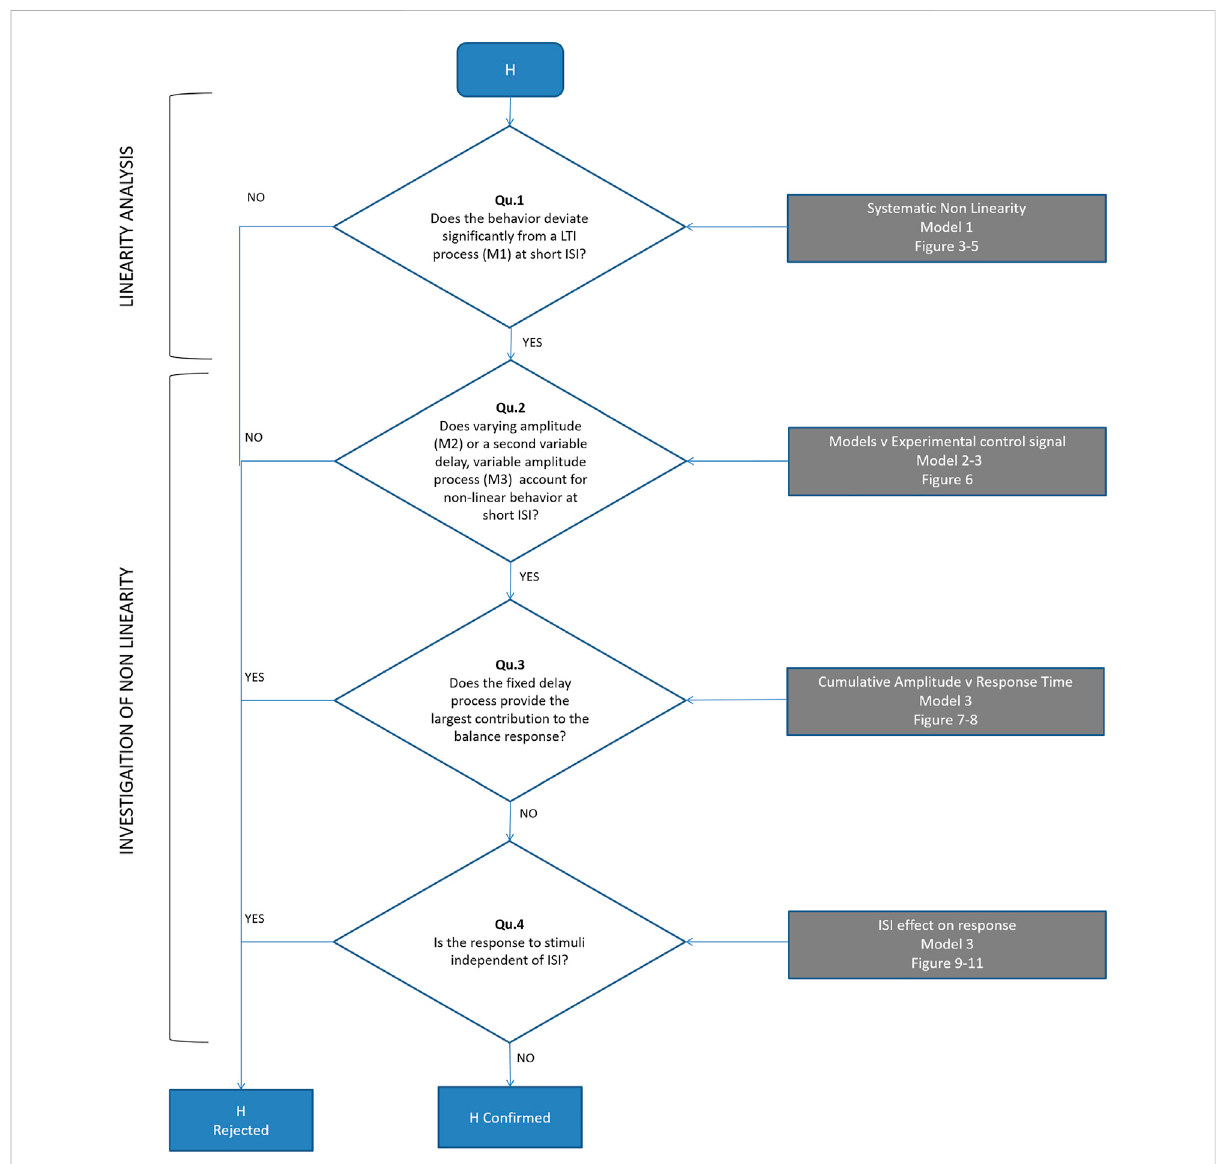
Flowchart to test our hypothesis (H): a single (re fl exive) pathway provides the minor contribution to balance. Qu 1) Does the experimental control signal u deviate signi fi cantly from a LTI process (M1) at short ISI? (Figures 4, 5). Qu 2) Does time varying amplitude (M2) or a second variable delay, variable amplitude process (M3) account for non-linear behavior of the control signal u at short ISI? (Figure 6). Qu 3) Does the fi xed delay process provide the largest contribution to the balance response? We calculated the cumulative amplitude v time of all discrete fi xed